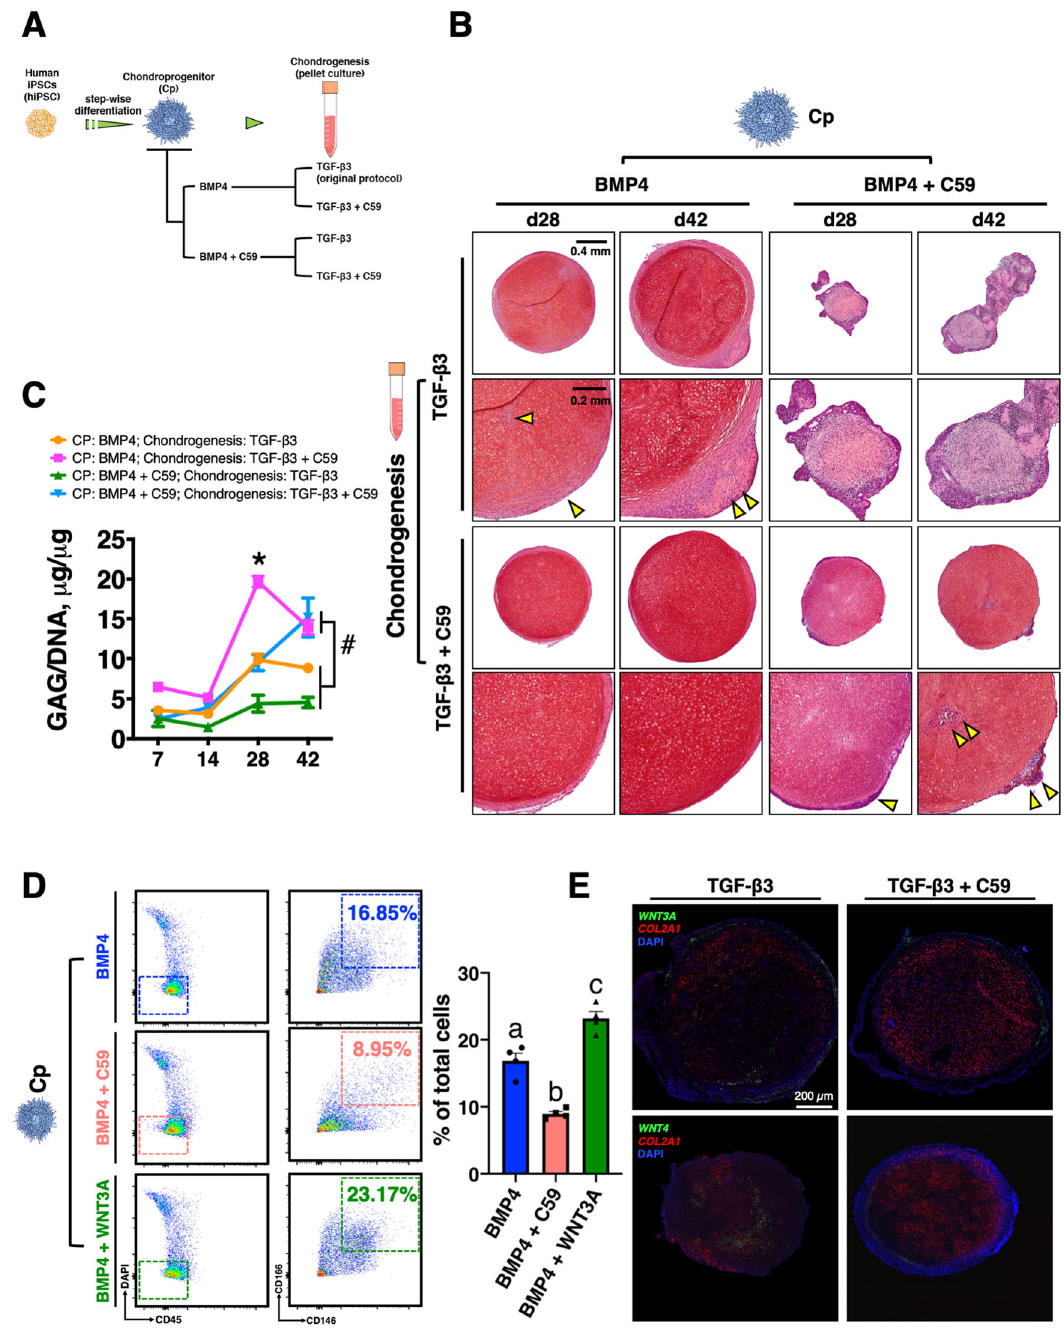
Fig. 4 WNT inhibition during pellet culture enhanced homogeneity of hiPSC chondrogenesis. A Experimental scheme of WNT inhibition. B C59 treatment during pellet culture enhanced Saf-O staining and decreased off-target cells (yellow arrowheads) as compared to other WNT inhibition culture regiments. Top row scale bar = 400 µ m. Bottom row scale bar = 200 µ m. The experiment was performed twice with similar results. C Pellets treated with C59 in only pellet culture exhibited an increased GAG/DNA ratio compared to pellets treated with other culture regiments. * p = 0.00001 at d28. # p = 0.0228 at d42. Mean ± SEM. n = 4 pellets per group. Statistical signi fi cance was determined by one-way ANOVA with Tukey ’ s post hoc test at a speci fi c time point. D C59 signi fi cantly decreased, but WNT3A signi fi cantly increased, CD146 + /CD166 + /CD45 − progenitors at the Cp stage. Different letters are signi fi cantly different (a vs. b, p = 0.0005; a vs. c, p = 0.0021; b vs. c, p = 0.0001). Mean ± SEM. n = 3 per group (independent experiment). Statistical signi fi cance was determined by one-way ANOVA with Tukey ’ s post hoc test. E RNA-FISH of d28 pellets showing C59-treated pellets had decreased WNT3A and WNT4 labeling (green) but more homogenous COL2A1 distribution (red) in the pellets. Scale bar = 200 µ m. The experiment was performed twice with similar